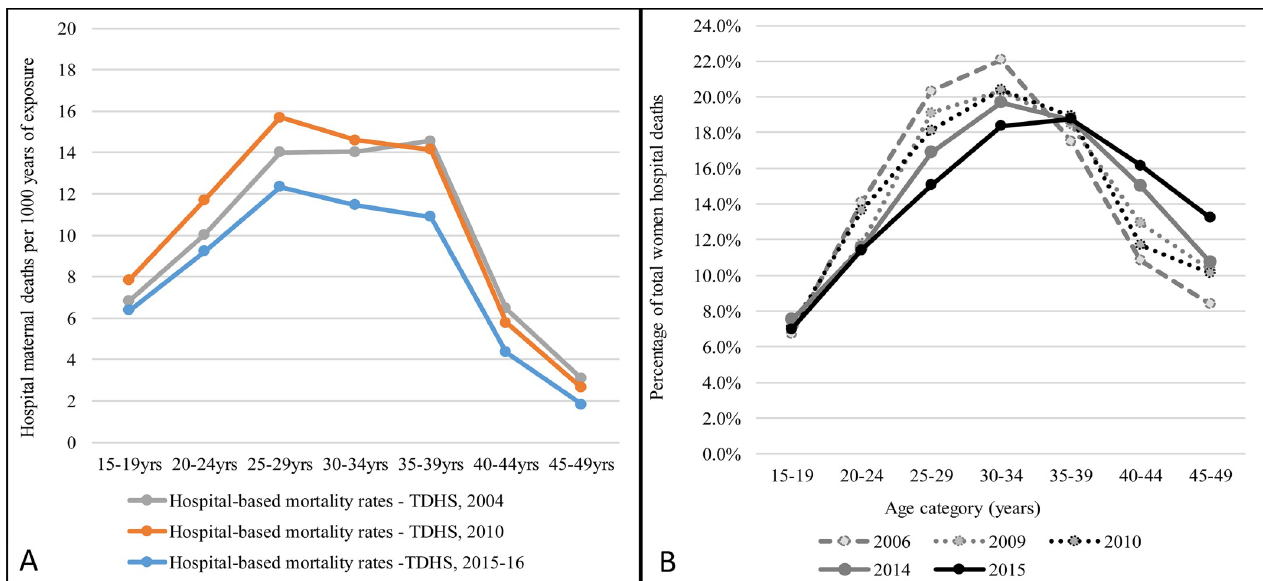
Fig 5. Age-specific hospital-based maternal mortality rates, 2006–2015.